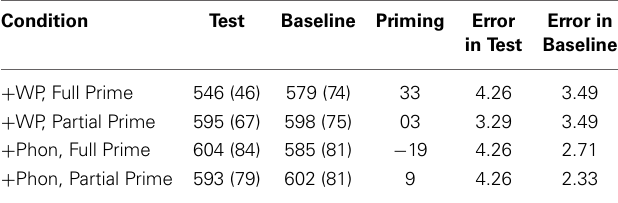
Table 4 | Reaction times, (standard deviations), amount of priming, and %error rates for the target preceded by test and baseline primes in the different conditions of experiment